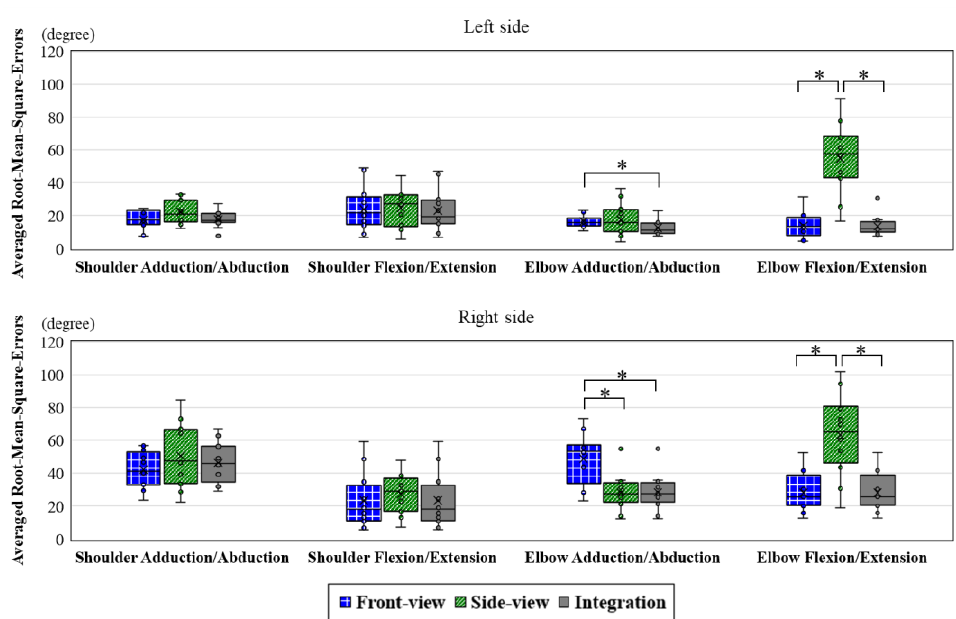
Figure 6. Comparison of the averaged root-mean-square error (RMSE) of the Front-view Kinect, the Side-view Kinect, and the Integration Kinect for adduction/abduction and flexion/extension movement estimates in each upper-limb segment (left shoulder/left elbow/right shoulder/right elbow). * indicates that there was a significant difference between the two datasets based on the Wilcoxon signed-rank test ( p -value < 0.05).